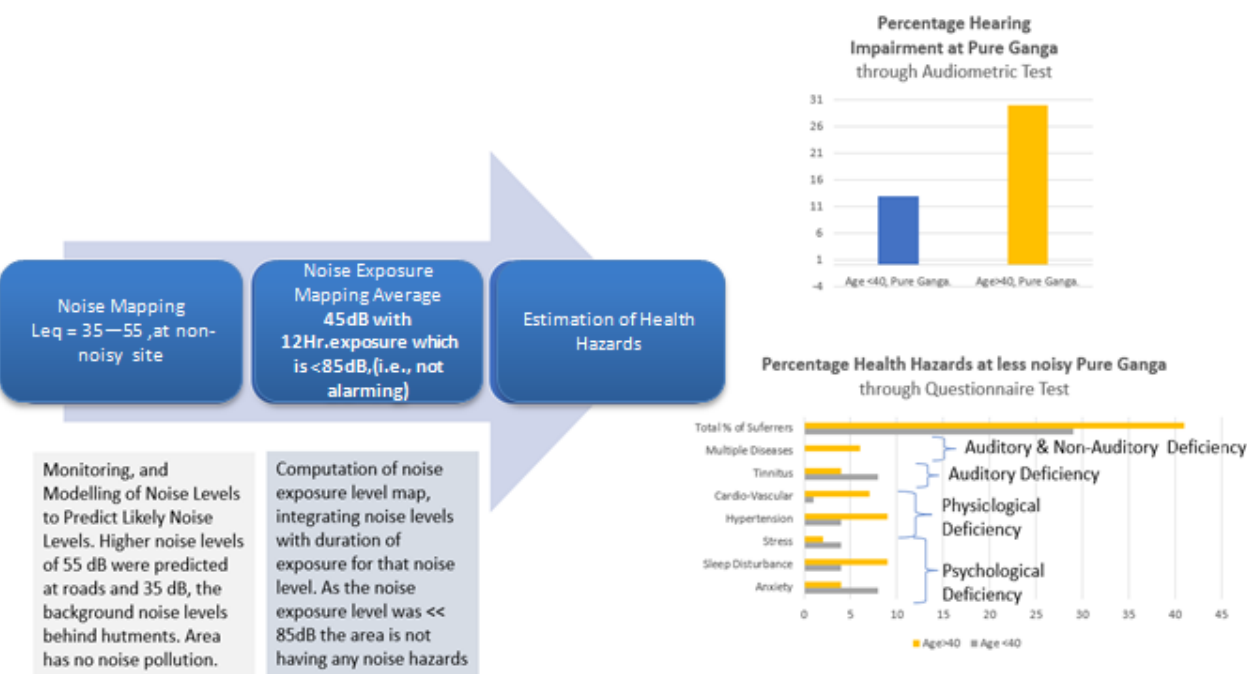
Figure 26. Health hazards of the noisy Bahadurpur area.